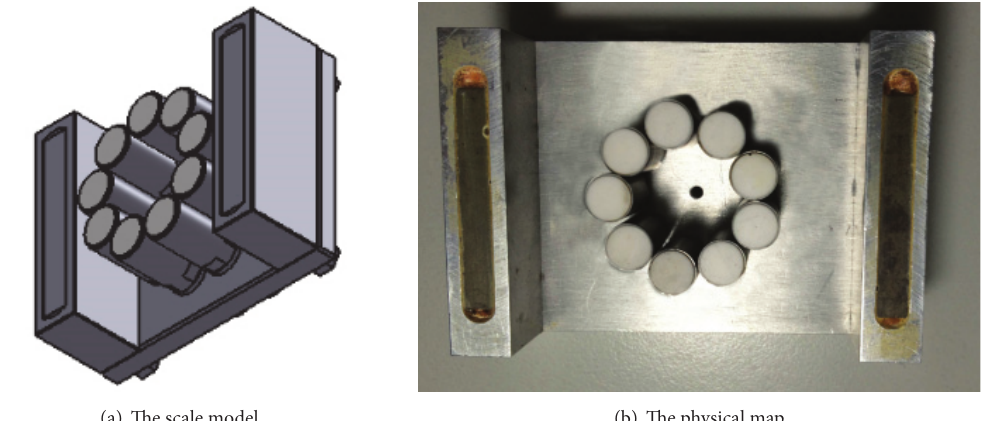
Figure 11: A nine-element circular ultrasonic array